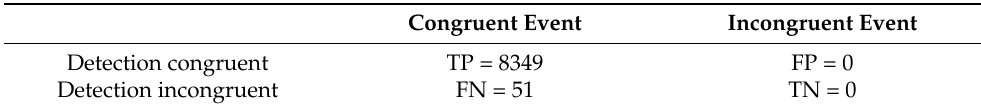
Table 6. Contingency table that assists with the detection of congruences in the Landsat 8 scene of the Doce River basin acquired in 2014 and consisting of 8400 tiles (TP—true positive, FP—false positive, FN—false negative, TN—true negative).